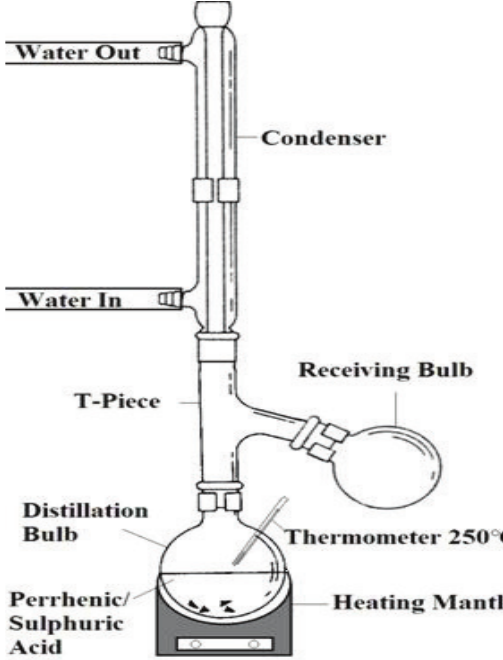
Figure 1: Distillation set up for the separation of perrhenic acid in